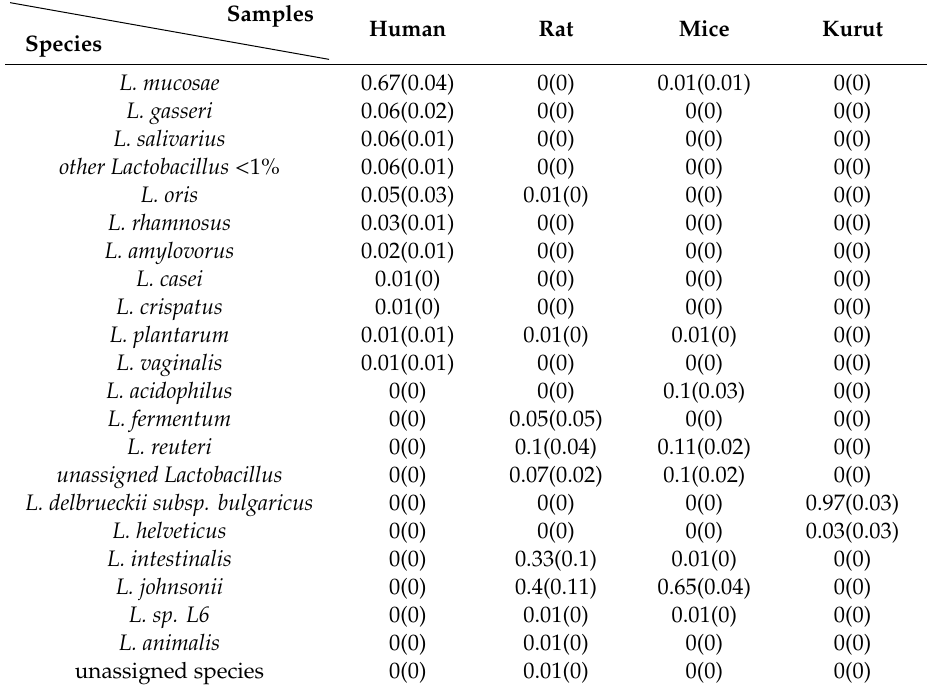
Table 2. groEL gene profiling method of the species composition of four di ff erent habitats 1